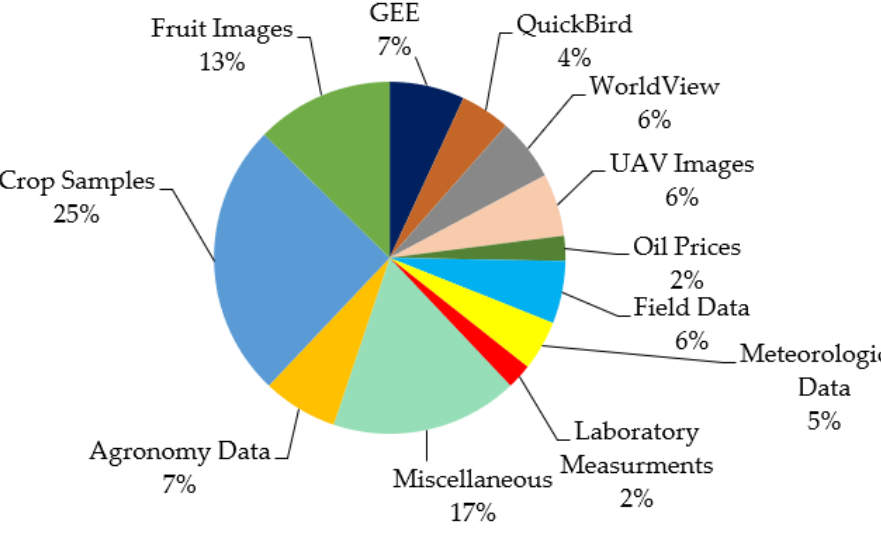
Figure 7. Datasets/sources mentioned in the articles.